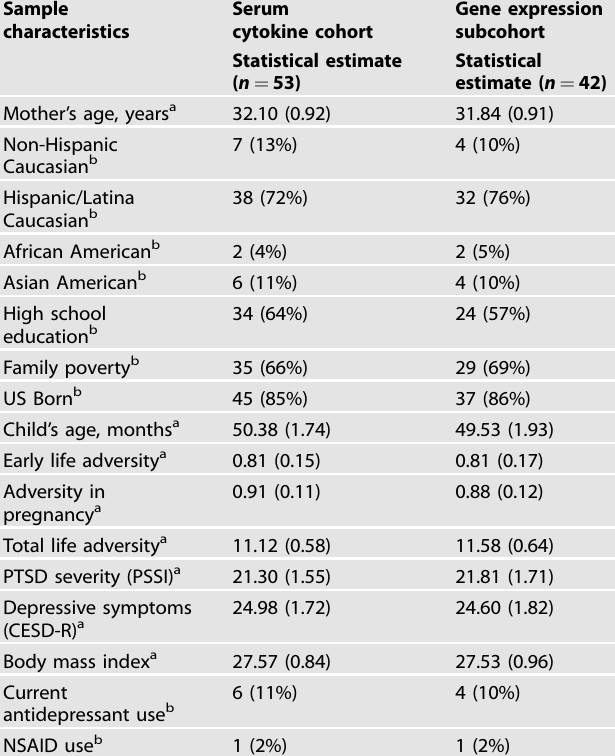
Table 1. Sociodemographic, adversity exposure, mental health, and medical characteristics of the